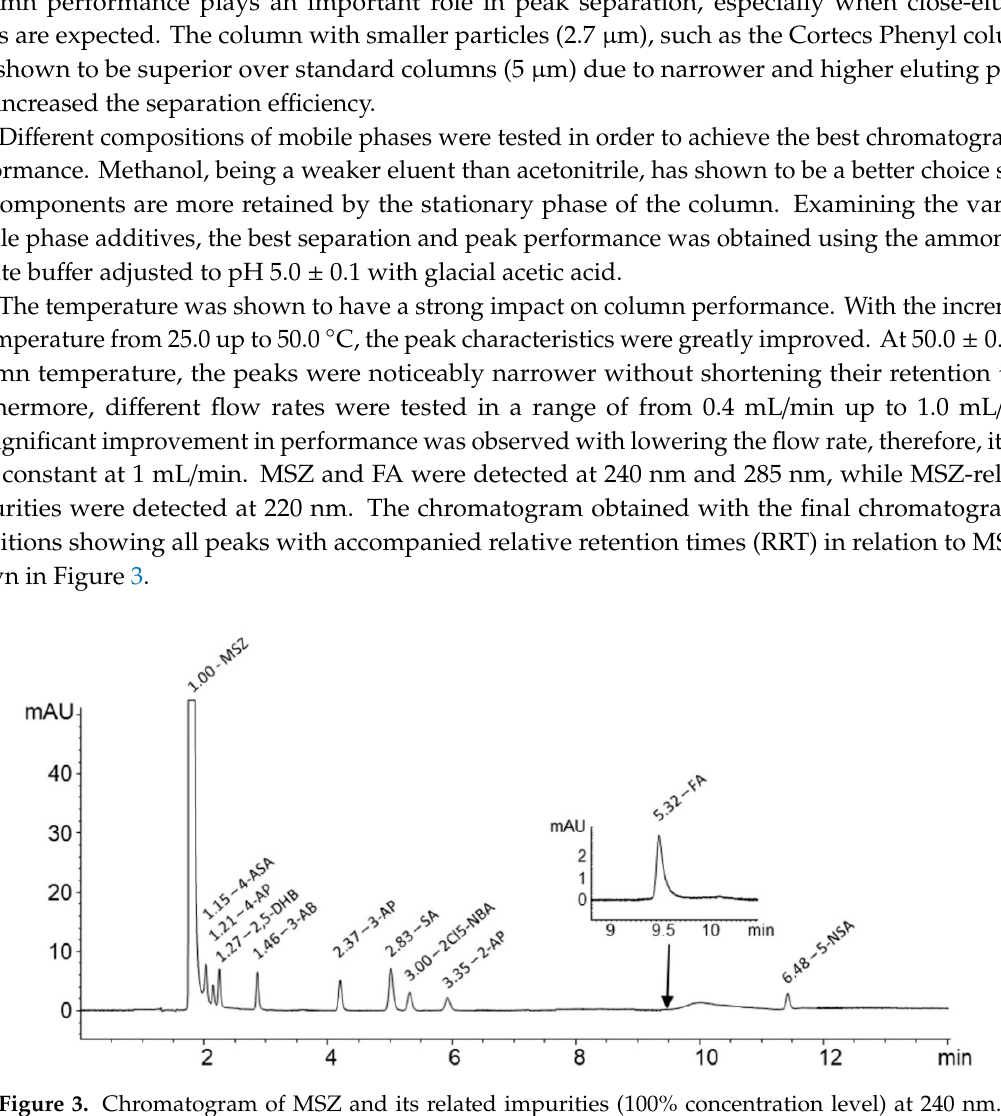
Figure 3. Chromatogram of MSZ and its related impurities (100% concentration level) at 240 nm. Insert shows FA peak at 285 nm. Hump at the 10th minute is due to the gradient.